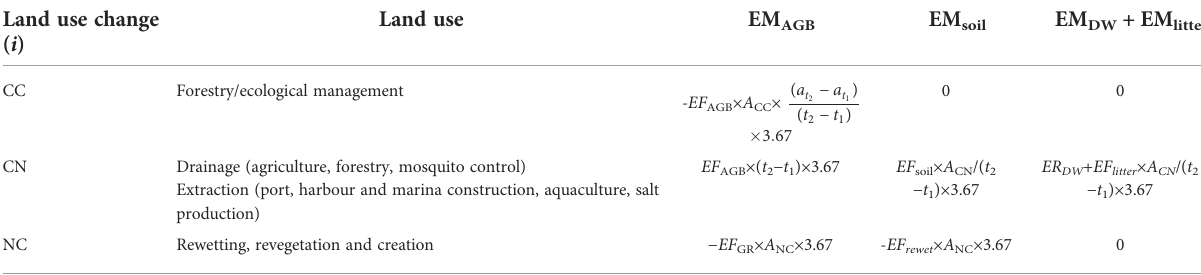
TABLE 1 EM CO calculation methods for different land-use change categories. 2 Land use change ( i